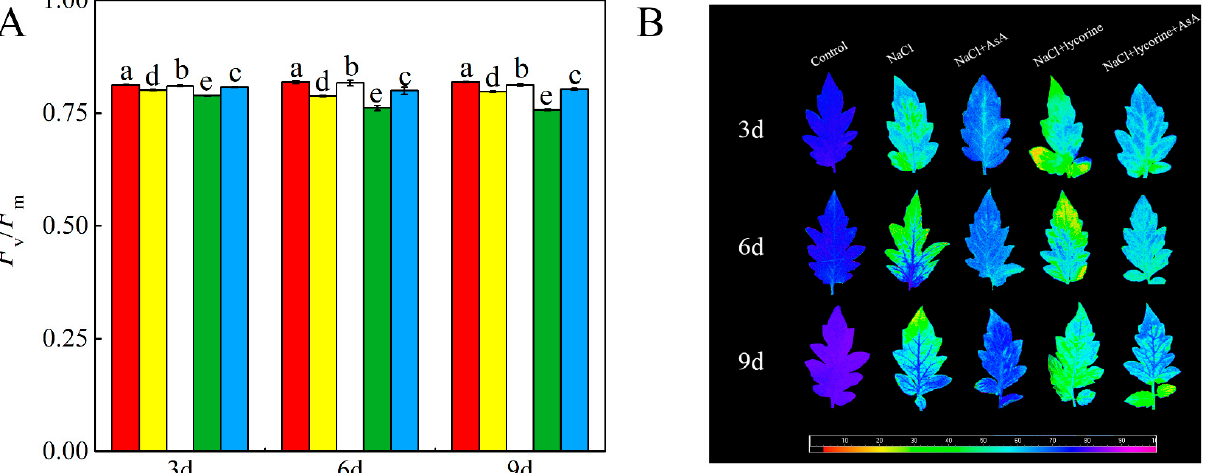
Figure 1. Values of the maximal photochemical efficiency of PSII ( F v / F m ) ( A ), false-color images of F v / F m ( B ), maximal P700 changes ( P m ) ( C ), non-photochemical quenching coefficient ( NPQ ) ( D ), pho- tochemical quenching coefficient ( qP ) ( E ), and PSII excitation pressure (1– qP ) ( F ) in leaves of salt- stressed tomato seedlings with or without exogenous reduced ascorbic acid (AsA) and lycorine (AsA synthesis inhibitor) spraying. Abbreviations 3d, 6d, and 9d represent the third, sixth, and ninth day after treatment, respectively. Control, no added NaCl and sprayed with distilled water; NaCl, added 100 mmol·L –1 NaCl and sprayed with distilled water; NaCl + AsA, added 100 mmol·L –1 NaCl and sprayed with 0.5 mmol·L –1 AsA; NaCl + lycorine, added 100 mmol·L –1 NaCl and sprayed with 0.25 mmol·L –1 lycorine; NaCl + lycorine + AsA, added 100 mmol·L –1 NaCl and sprayed with 0.25 mmol·L –1 lycorine plus 0.5 mmol·L –1 AsA. Values are means ± SD ( n = 3). Values with a different letter within a sampling date are significantly different ( p < 0.05).